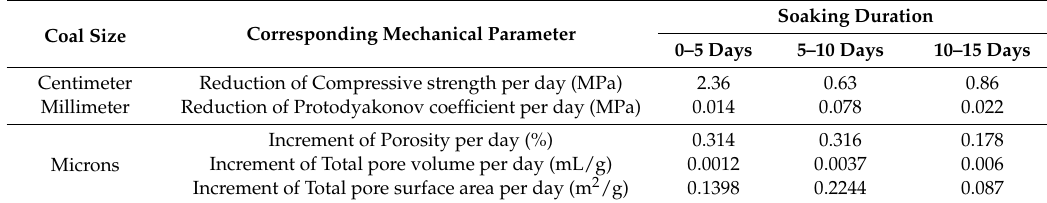
Table 9. Relationship between mechanical parameters of different size coal and soaking